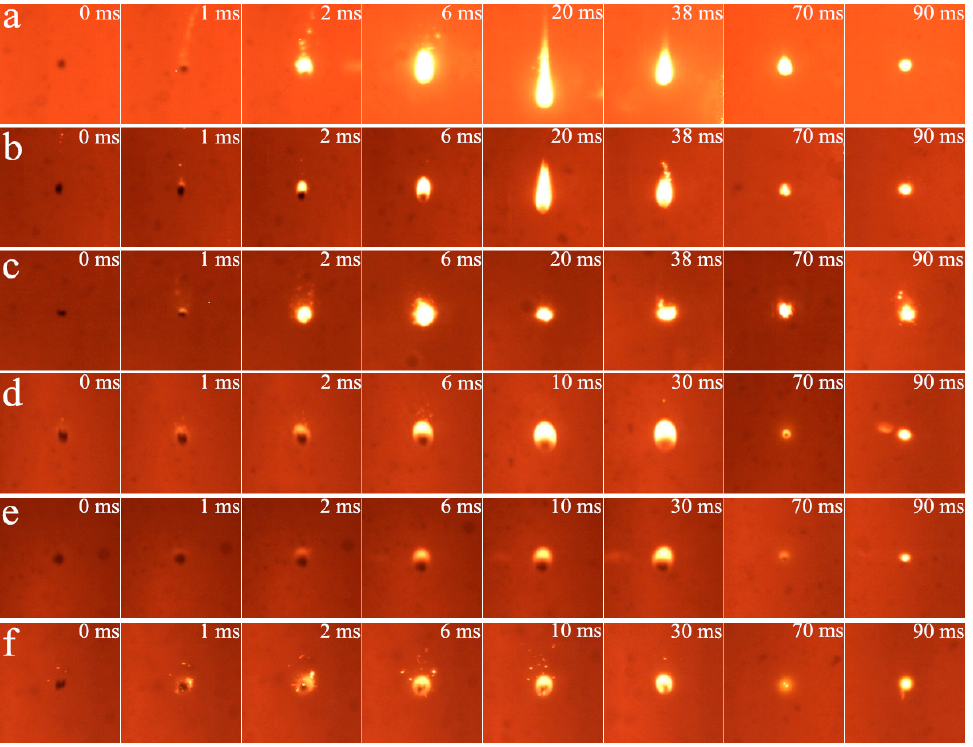
Figure 4. The influences of diluent gas on the combustion characteristics of BC and PS particles. ( a ) BC-21%O 2 + 79%N 2 ; ( b ) BC-21%O 2 + 79%CO 2 ; ( c ) BC-21%O 2 + 79%H 2 O; ( d ) PS-21%O 2 + 79%N 2 ; ( e ) PS-21%O 2 + 79%CO 2 ; and ( f ) PS-21%O 2 + 79%H 2 O.